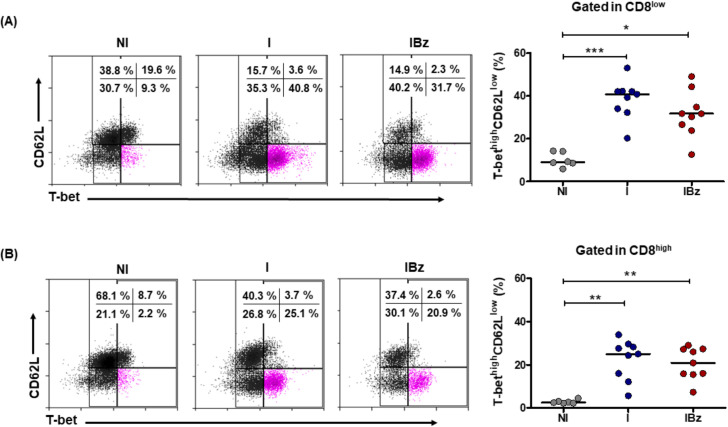
Benznidazole-treated mice display elevated frequency of CD8lowCD62LlowT-bethigh effector memory cells.(A) Frequency of CD62LlowT-bethigh cells within CD8low subset was analyzed from non-infected and non-treated (NI), infected non-treated (I) and infected and benznidazole-treated (IBz). (B) Frequency of CD62LlowT-bethigh cells within CD8high subset were analyzed from NI, I and IBz groups. Respective representative dotplots (T-bet versus CD62L) are shown. Data are from two experiments with n = 6 in NI group, and with n = 4 and 5 mice per experiment in I and IBz. Data were analyzed on day 14 post-infection; horizontal bars represent the average for each group; *p < 0.05, ** P <0.01, ***p < 0.001 unpaired Kruskal-Wallis (Dunn's post-test).